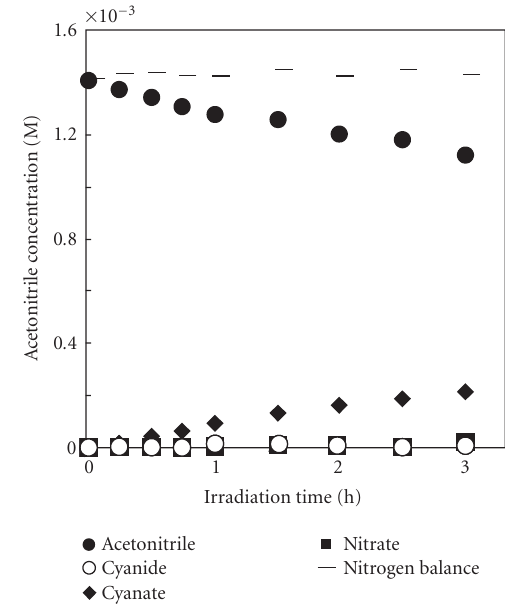
Figure 8: Acetonitrile photocatalytic degradation in liquid-solid regime: concentrations of acetonitrile ( ), cyanide ( (cid:3) ), cyanate ( (cid:3) ), nitrate ( (cid:2) ), and nitrogen balance (–) versus irradiation time. Catalyst: TiO 2